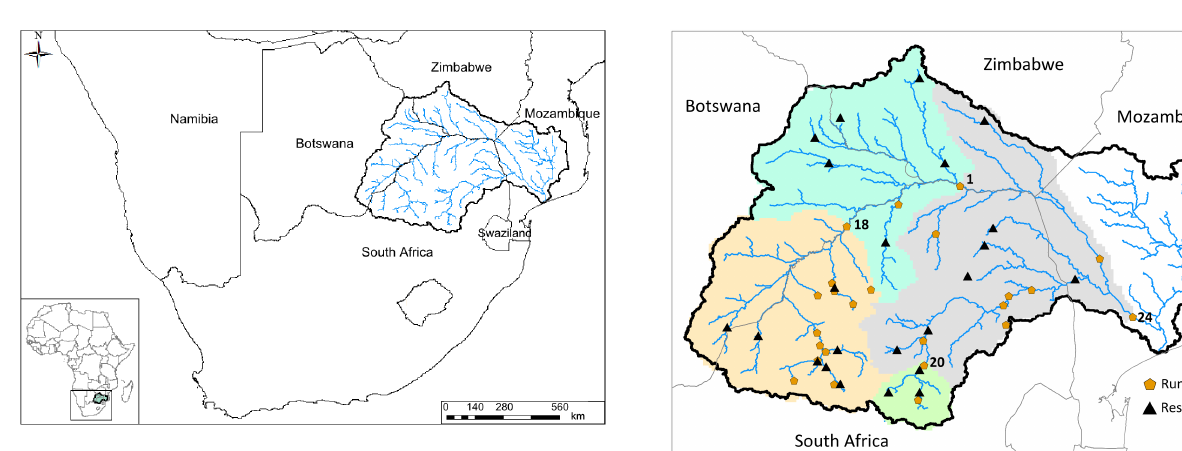
Figure 2. Location of the Limpopo River basin.